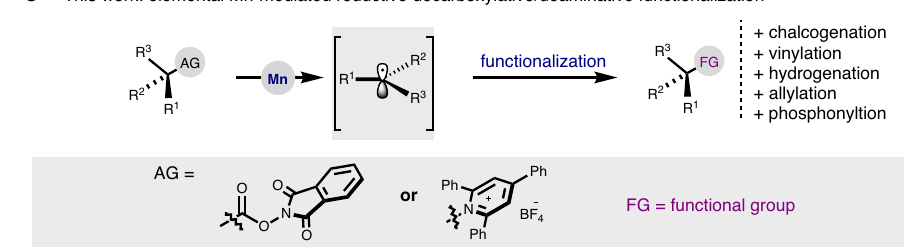
Fig. 1 Barbier reaction and strategies of decarboxylative/deaminative functionalization. a Barbier coupling reaction. b Previous work: decarboxylative/ deaminative functionalization. c This work: elemental Mn-mediated reductive decarboxylative/deaminative